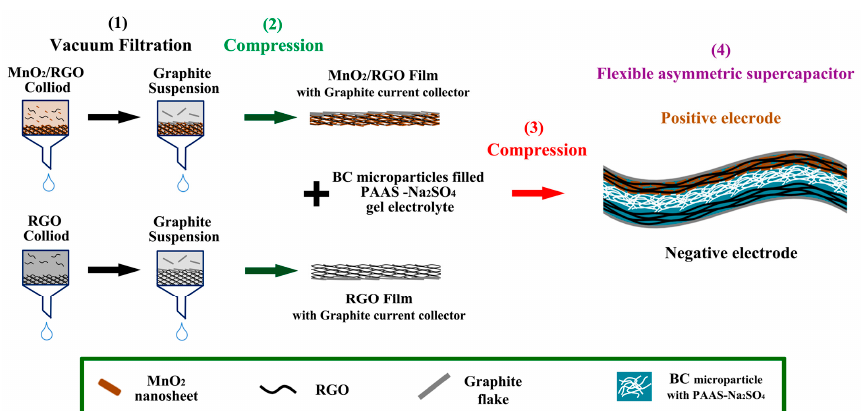
Figure 3. Schematic illustration of the preparation process. ( 1 ) Vacuum filtration of MnO 2 /RGO, RGO colloidal suspensions and graphite flakes suspension; ( 2 ) Compression to obtain MnO 2 /RGO and RGO hydrogel films with an attached graphite current collector; ( 3 ) Compression to assemble the flexible supercapacitor (SC) with obtained hydrogel films and the BC/PAAS-Na 2 SO4 gel electrolyte; ( 4 ) Schematic structure of the assembled flexible asymmetric SC, demonstrating the role of the separation of bacterial cellulose